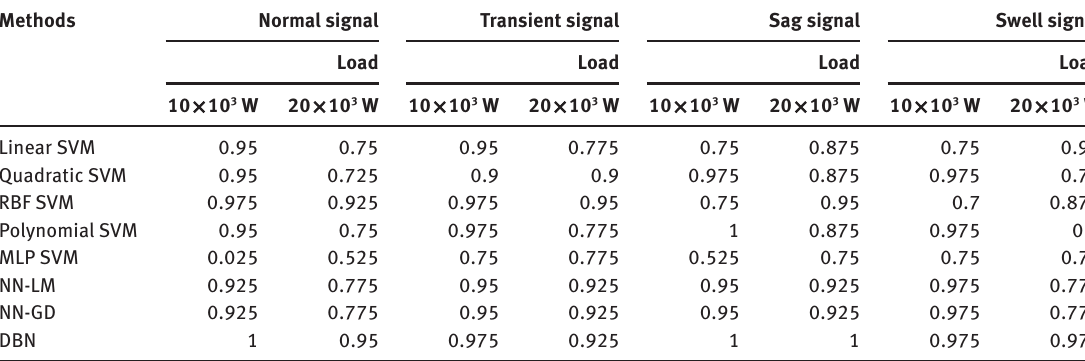
Table 6: Fault Recognition Accuracy at Different Loading Effects.